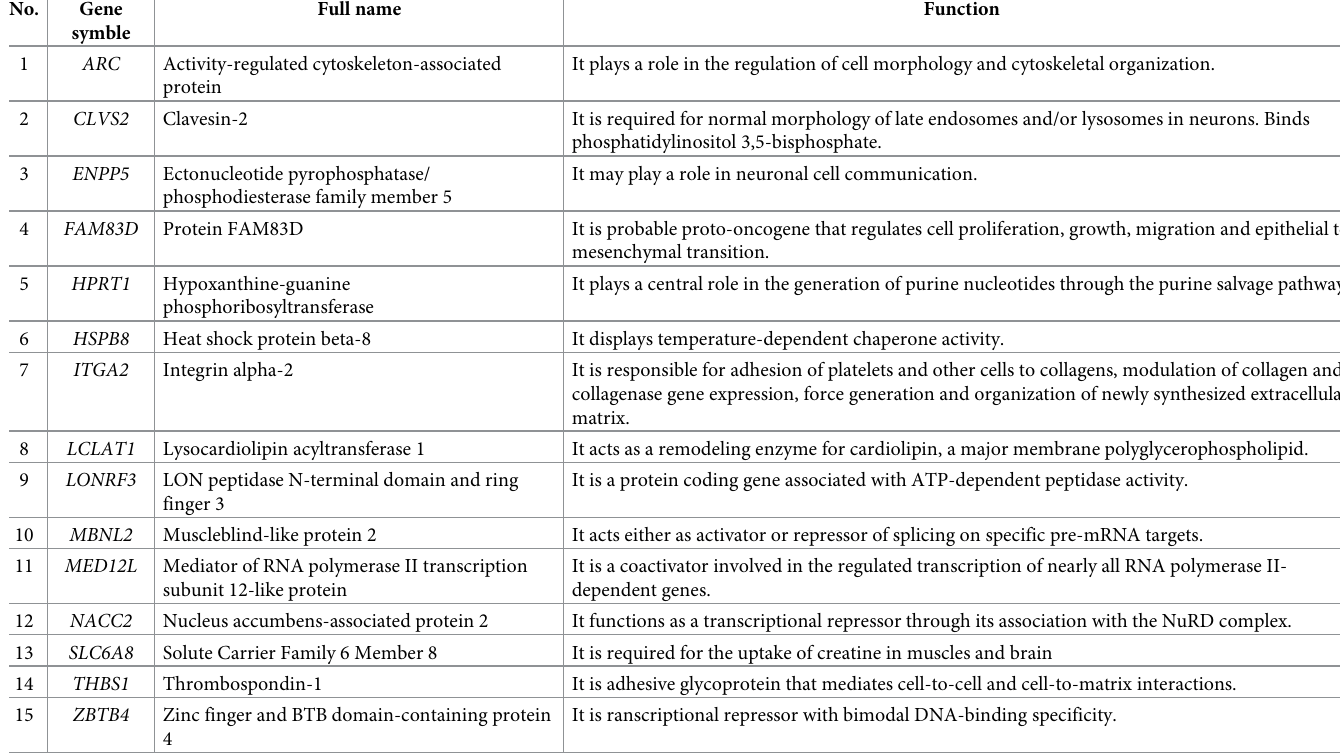
Table 2. Functional roles of 15 hub